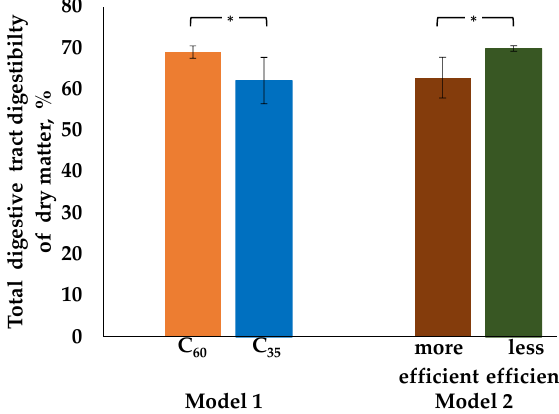
Figure 5. Total digestive tract digestibility of dry matter for the week of duodenal chyme sampling (on average week 13 postpartum ± 16 days). After calving cows were assigned to a group with 60% concentrate feed proportion (increasing from 35 to 60% during the first three weeks after parturition, C 60 , orange , n = 5) and a group with 35% concentrate feed proportion ( C 35 , blue , n = 4) in the ration (model 1). For the week of duodenal chyme sampling, cows were additionally grouped into a more (206 ± 17 g/kg, red , n=5) and a less efficient (122 ± 17 g/kg, green , n = 4) group in compliance with the average microbial efficiency of 156 g /kg, defined as synthesized microbial crude protein/fermented organic matter according to GfE [15] (model 2). *Indicating significant group differences. C 60 vs. C 35 : p -value = 0.030, more efficient vs less efficient: p -value = 0.026. The same is true for the total digestive tract digestibility quotient of OM ( p c = 0.003, p mCP/fOM = 0.027, Table 9). C 60 and C 35 animals did not differ in their total digestive tract digestibility quotient of aNDF om and ADF om (Table 9). Furthermore, the less efficient group had a significantly higher total digestive tract digestibility quotients of aNDF om ( p mCP/fOM = 0.036, Table 9) and ADF om ( p mCP/fOM =